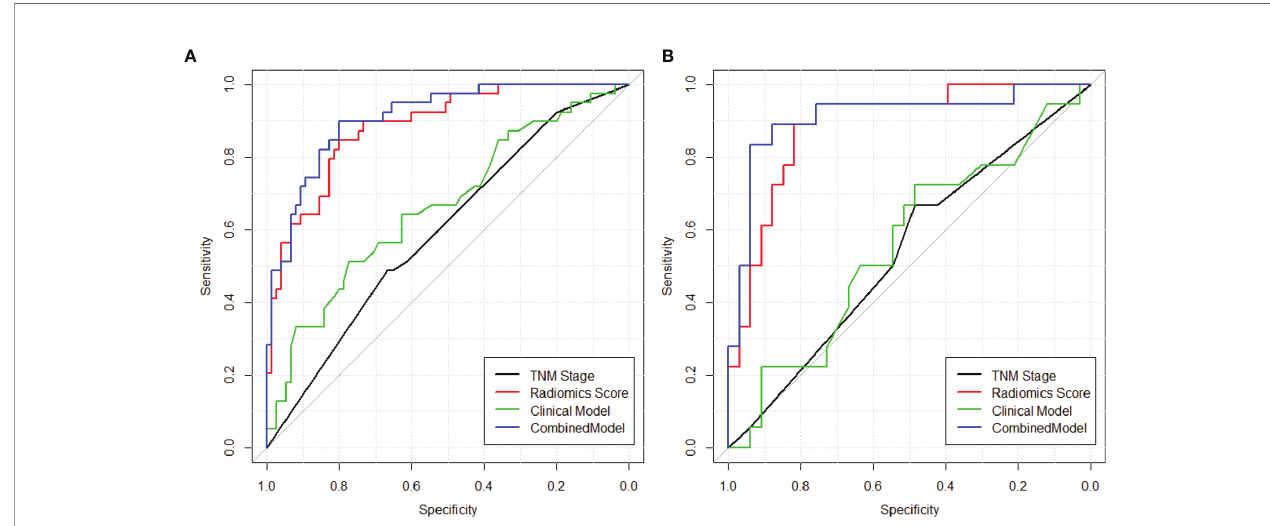
FIGURE 6 | ROC curves showing the prognostic power in estimating 5-year OS in both (A) training and (B) validation sets using (1) TNM staging (2), clinical model with clinical-histopathological-radiological (non-radiomics) risk factors, (3) radiomics score, and (4) combined model with both radiomics and non-radiomics